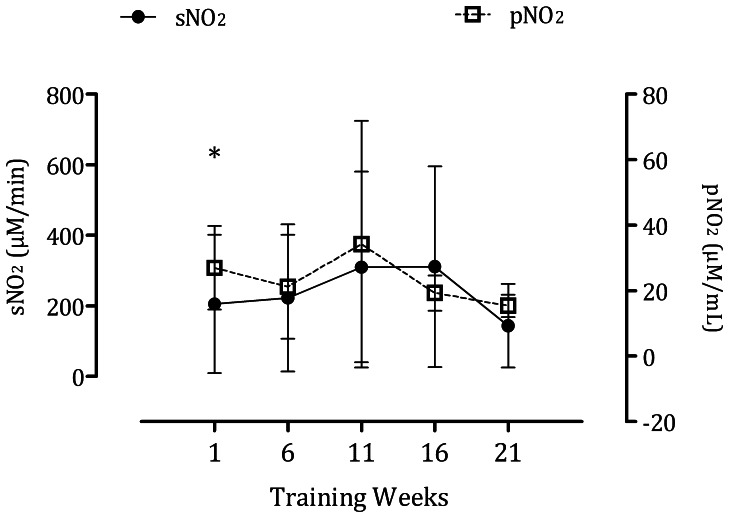
Plasma and salivary nitrite.*Different from Training Week 21 (pNO2).